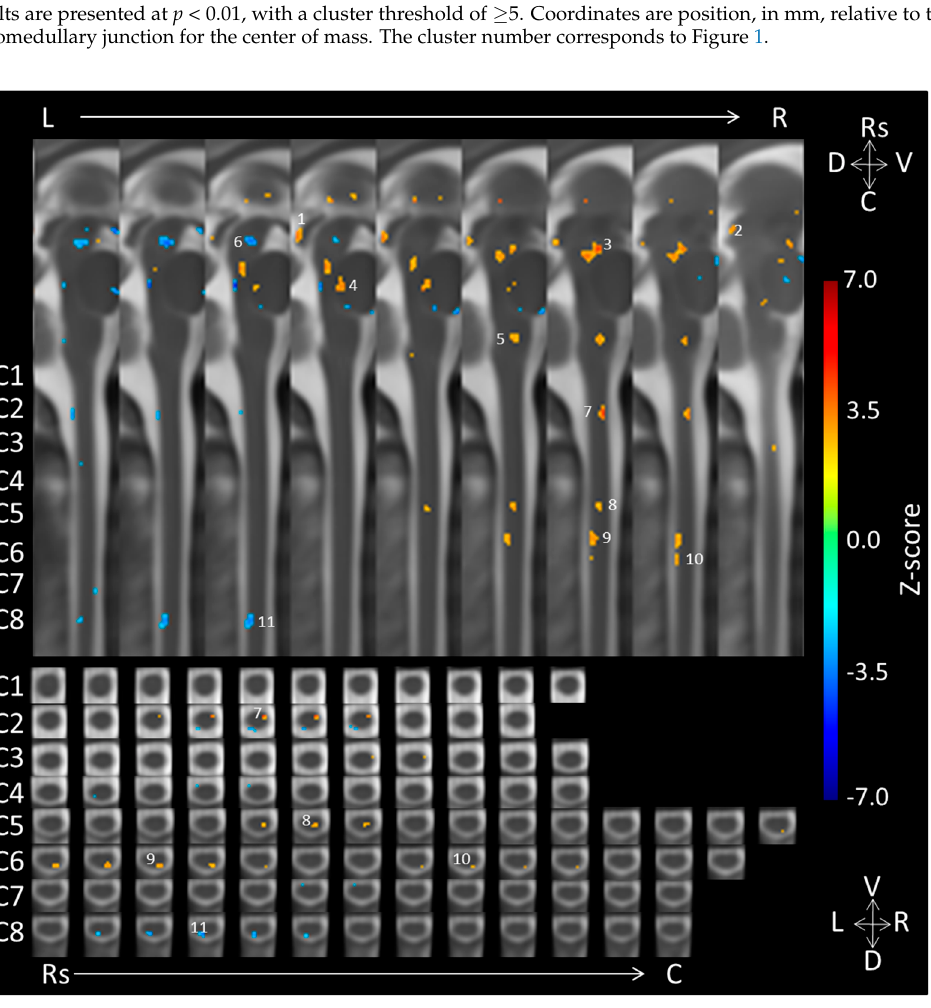
Figure 1. Group-level midbrain, brainstem and cervical spinal cord activity for the negative > neutral sounds contrast ( p = 0.01; n = 17). Cervical spinal cord segments are labeled on the left of the figure for both sagittal and axial views. Voxels in orange represent significant activity for the negative as compared to the neutral condition and voxels in blue represent significant activity for the neutral as compared to the negative condition. Sagittal (above) and axial (below) views allow for Rs = rostral, C = caudal, D = dorsal, V = ventral, R = right, and L = left localization. Numbers 1–11 correspond to the clusters listed in Tables 1 and 2.